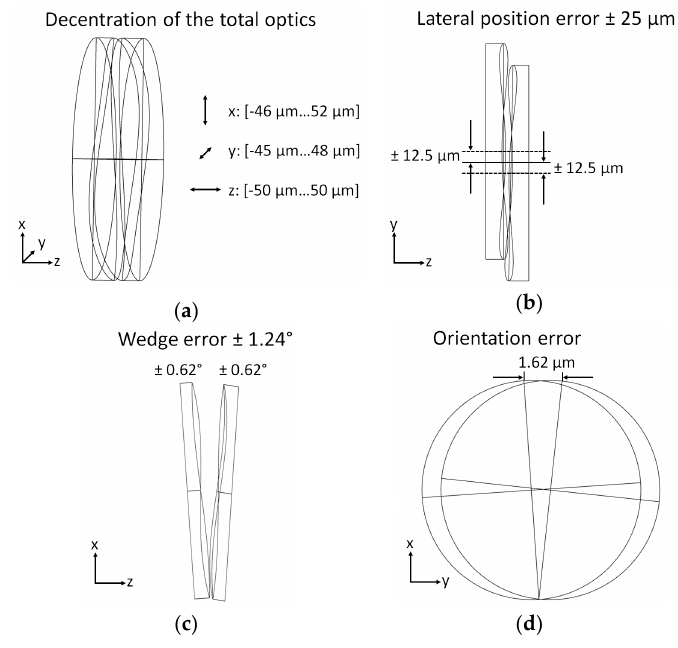
Figure 10. Different types of position errors identified for the AH optics.